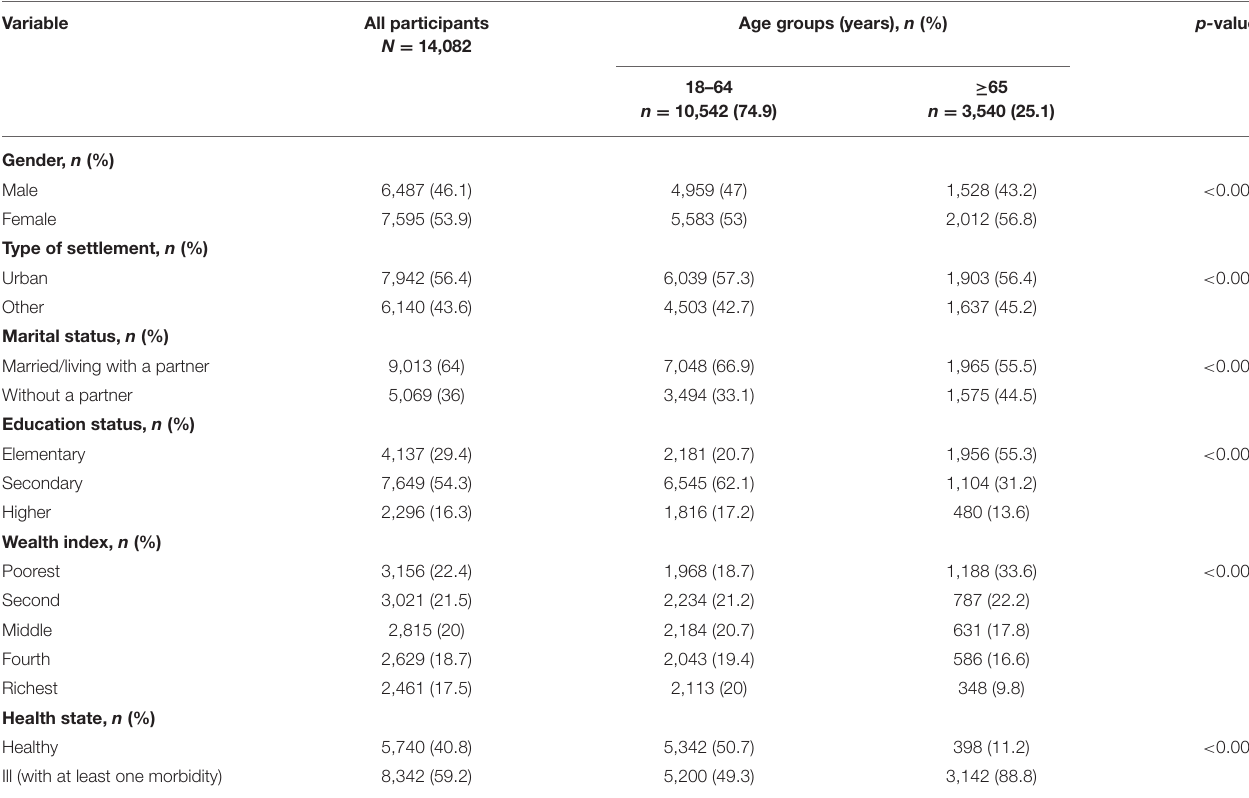
TABLE 1 | Demographic, socioeconomic, and health state characteristics of the study participants by age groups.